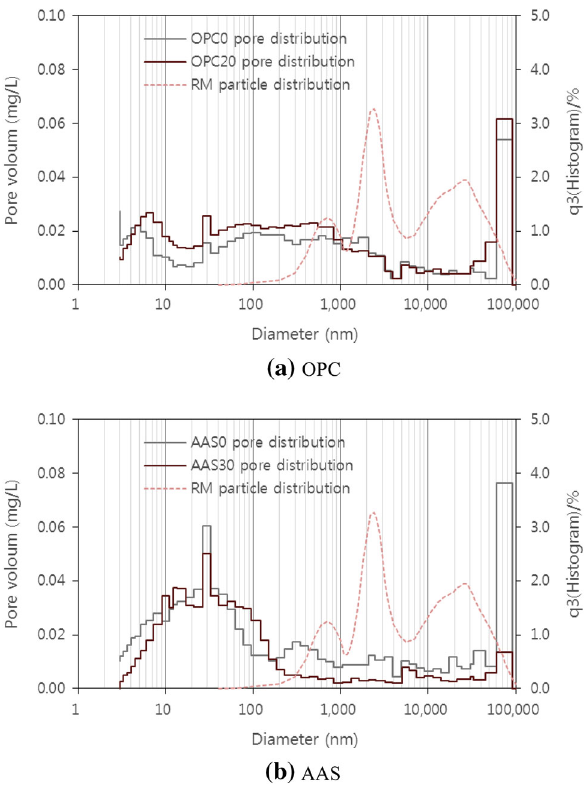
Fig. 9 Pore size distribution with red mud replacement ratio.